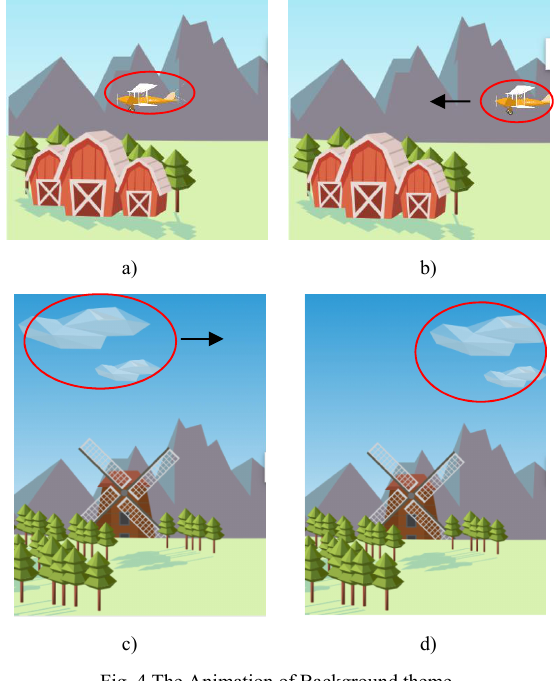
Fig. 4 The Animation of Background theme